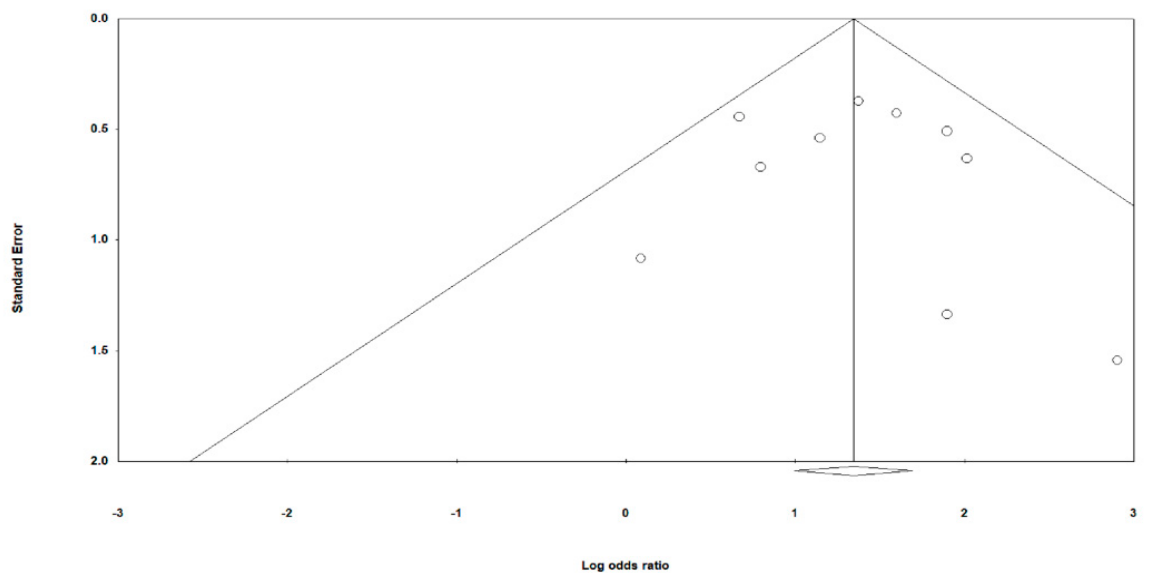
Figure 10. Risk-of-bias assessment of the studies. High risk of bias was marked as red (-), low risk of bias was marked as green (+) and unclear risk of bias was marked as yellow (?).